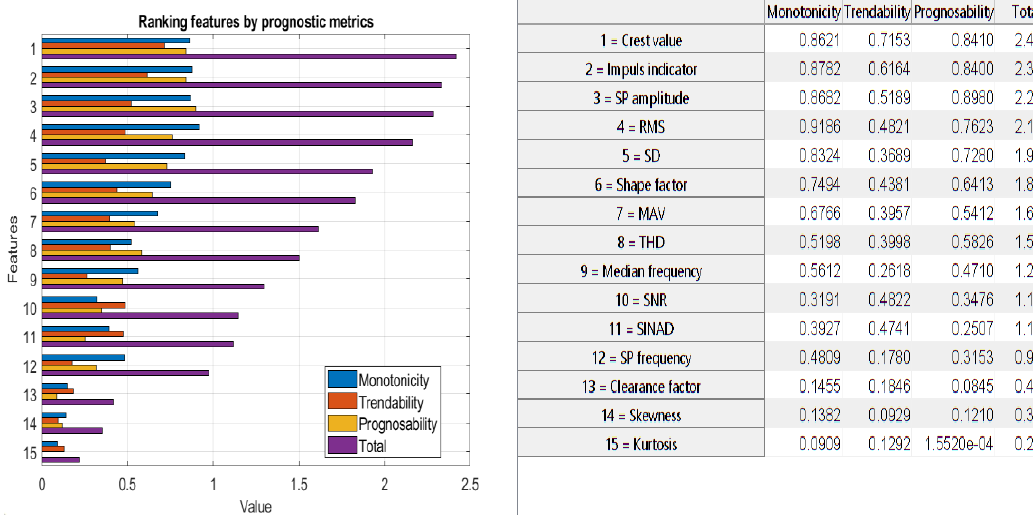
Figure 6. Order of extracted features. The left-side figure illustrates the order features and the right-side table presents the name of features and their corresponding values. Features are ranked in descending order based on their total score. The total score of a feature is calculated based on the sum of monotonicity, trendability and prognosability.